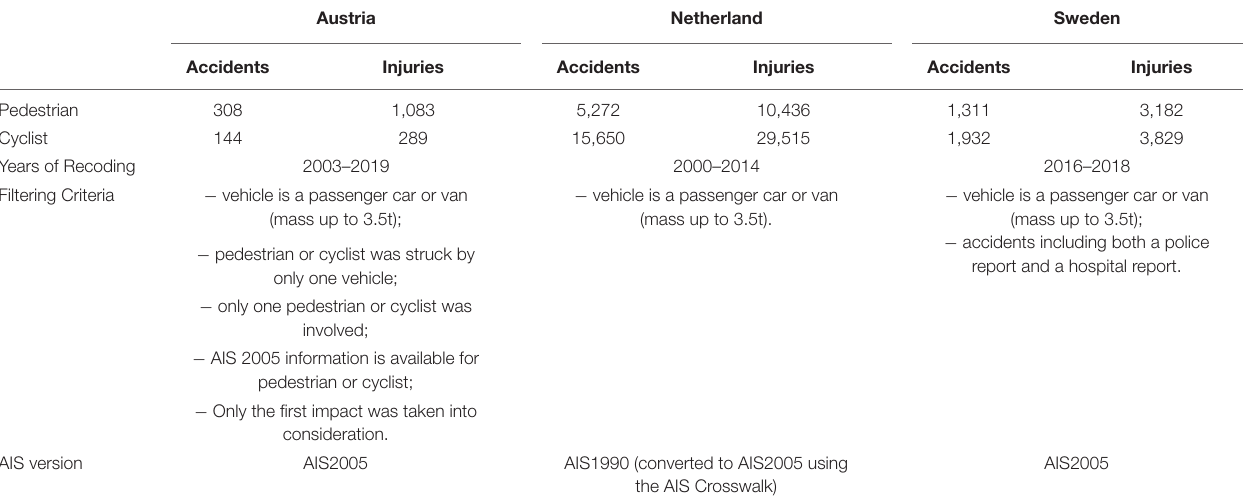
TABLE 1 | Summary of accident data used for injury